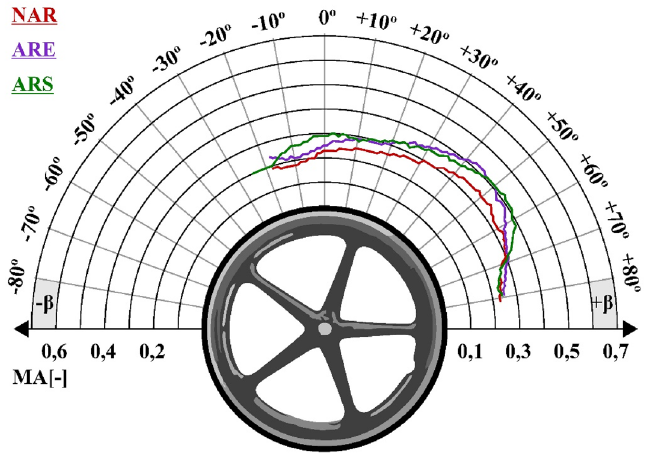
Figure 14. Graphs of the average total muscular effort of the upper limb as a function of its position on the push-rim. In the graphs: NAR—wheelchair without an anti-rollback system, ARS—wheelchair with a stiff anti- rollback system, ARE—wheelchair with a flexible anti-rollback